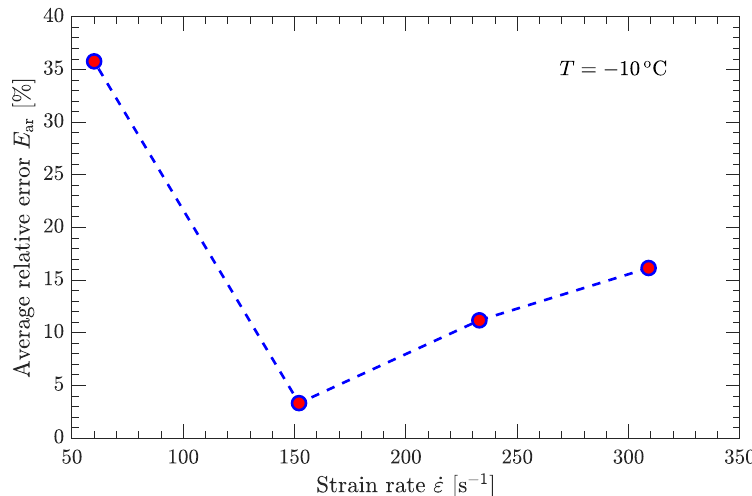
Figure 12. Average relative error between fitted and measured flow